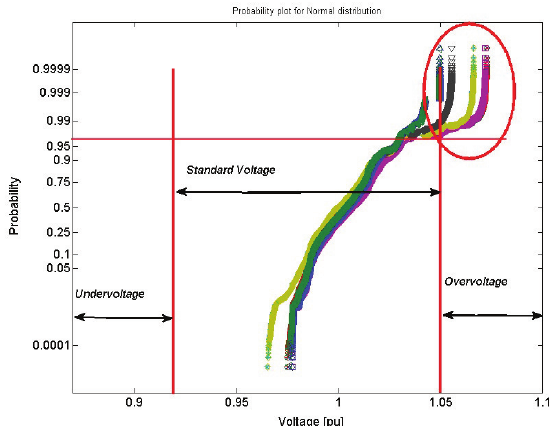
Figure 9. Distribution probability of voltage regulation curves in the FirstEnergy/PJM transmission system for the EC02 cases 1–9 with a voltage violation.